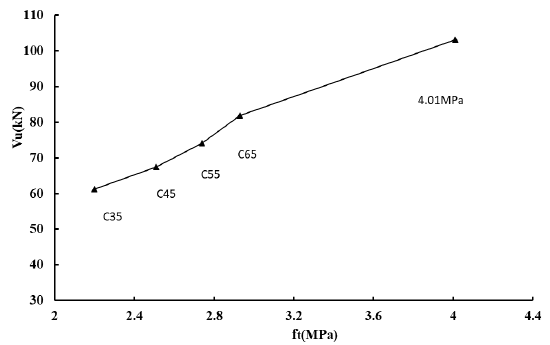
Figure 11. The curve of V u versus f t .